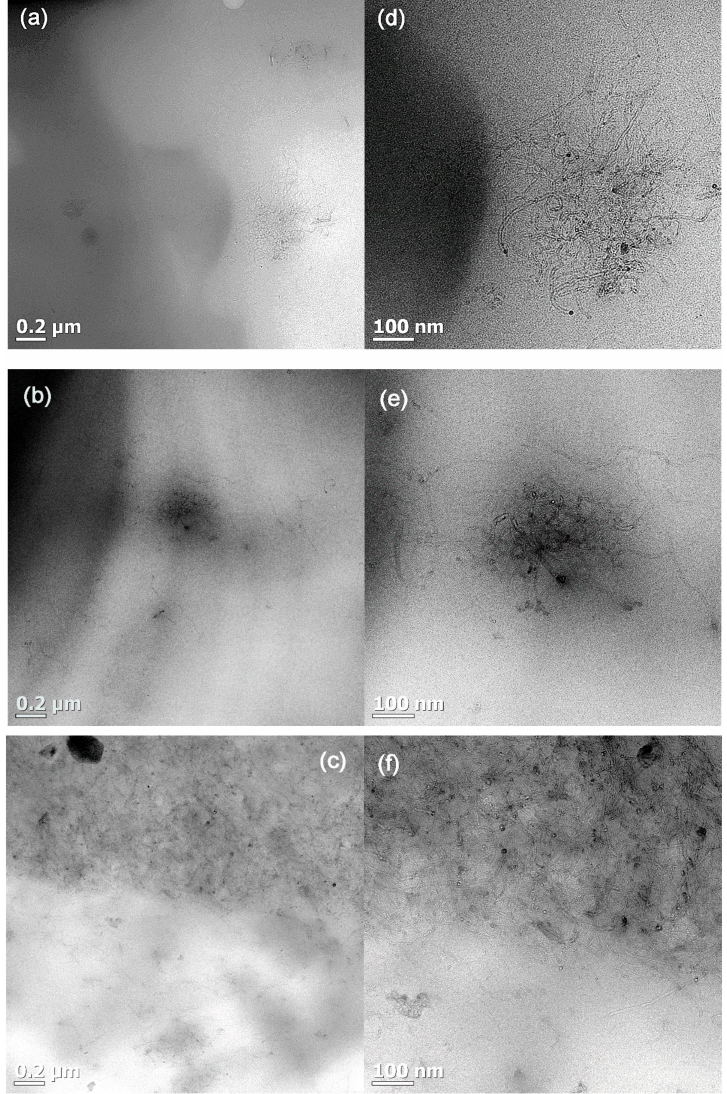
Figure 8. High and low magnification TEM micrographs for ( a , d ) 1.0 wt %, ( b , e ) 2.0 wt %, and ( c , f ) 4.0 wt % MWCNTs in the PCL/(PC/MWCNT)